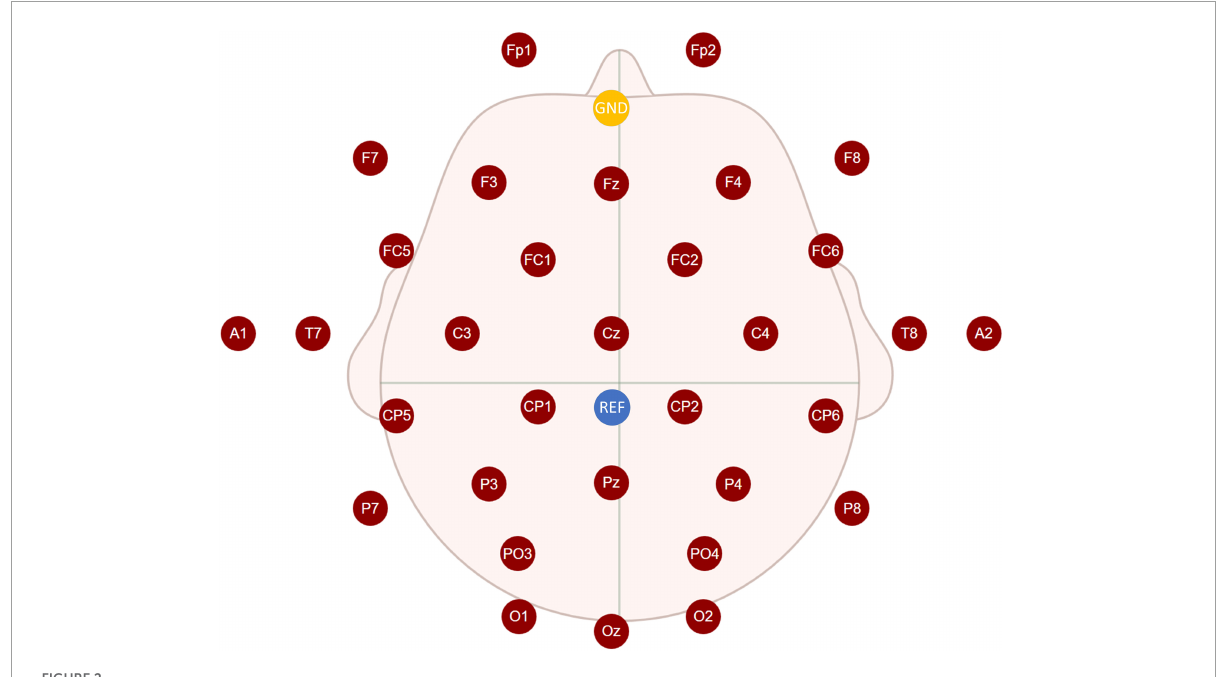
FIGURE2 Locations of all electrodes.